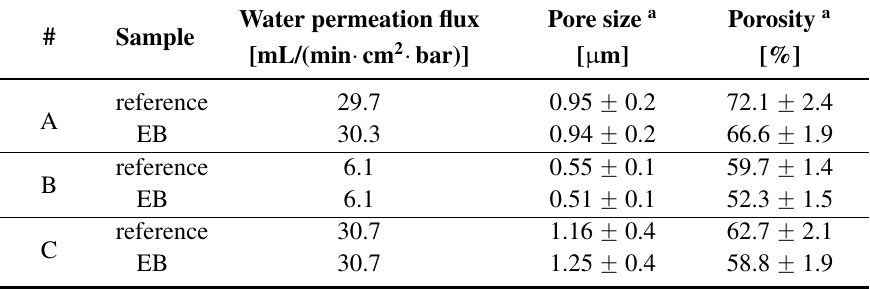
Table 3. Membrane properties before (reference) and after electron beam (EB) treatment